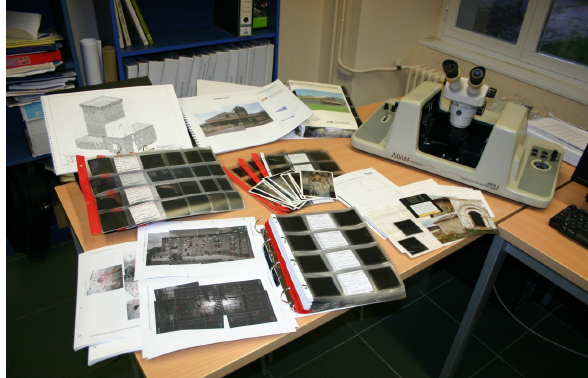
Figure 2. Display of a stereoplotter for analog photographs, Adam MSP-2 (at present, out of order), together with several folders with 6x6 cm negatives of some projects, plans, sketches with the distribution of the control points, complementary photographs, etc. The description of the analog equipment (e.g. cameras or stereoplotters) can be found in reference texts of that time (such as Atkinson,